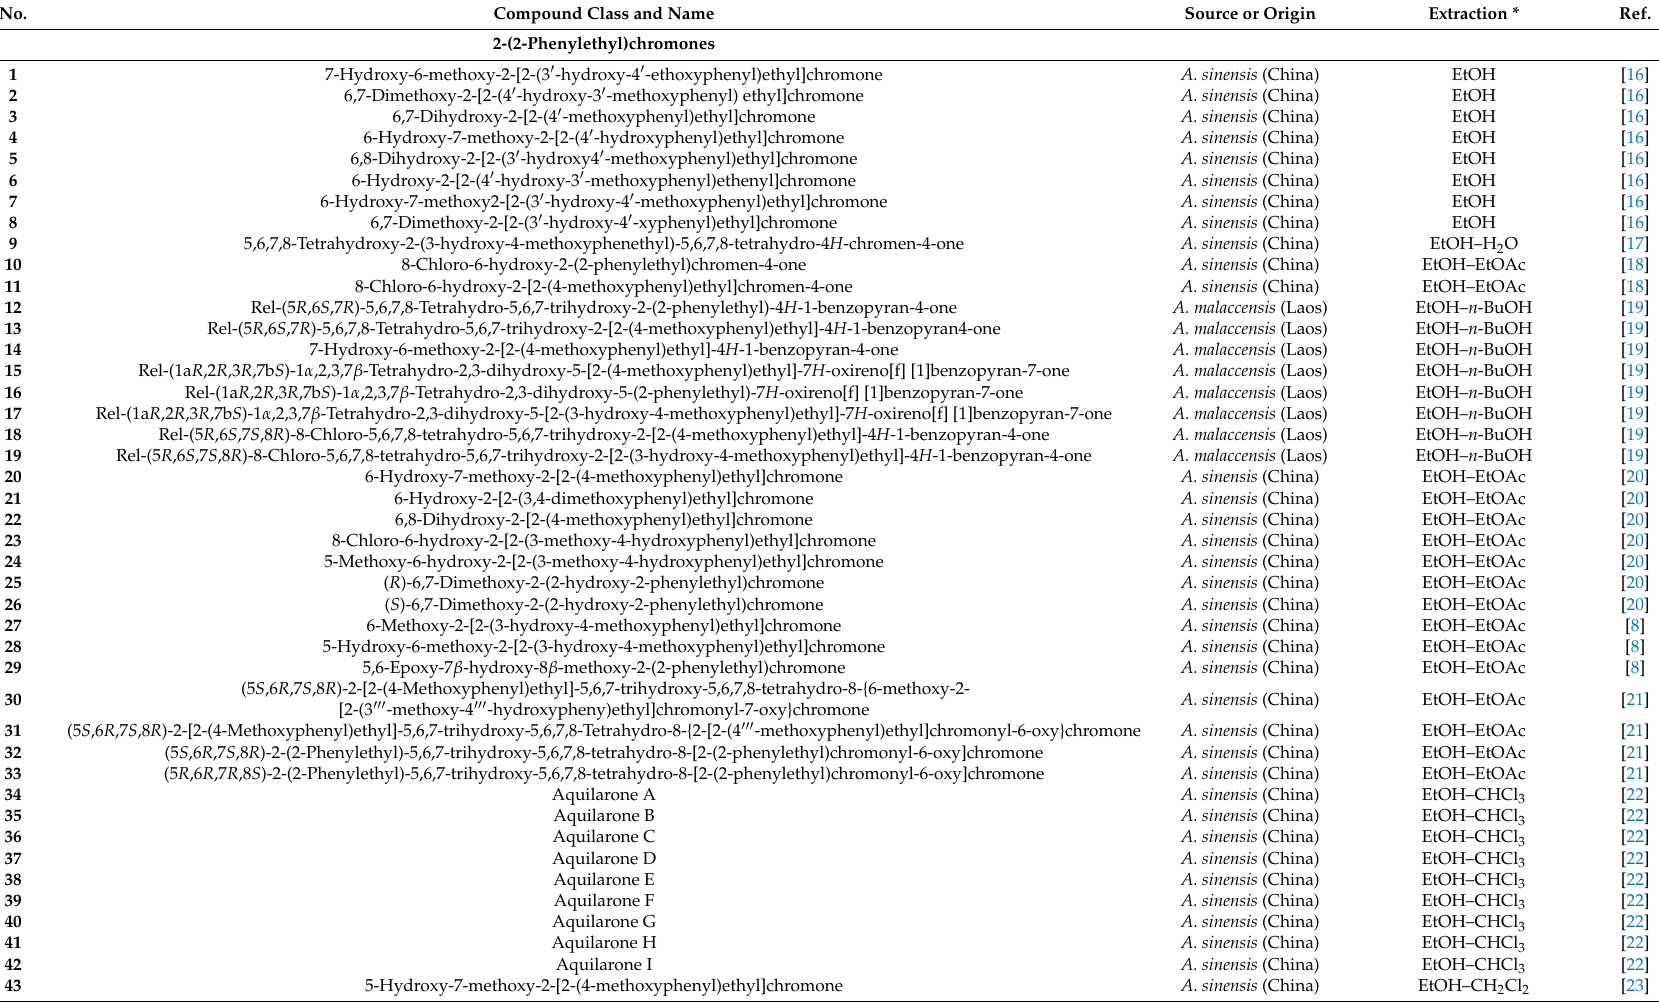
Table 1. Chemical constituents of agarwood originating from the genus